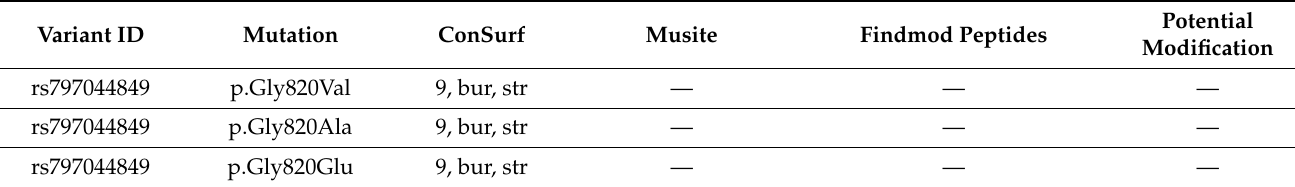
Table 3. Conservation Analysis, PTMs, predicted PTM sites, and